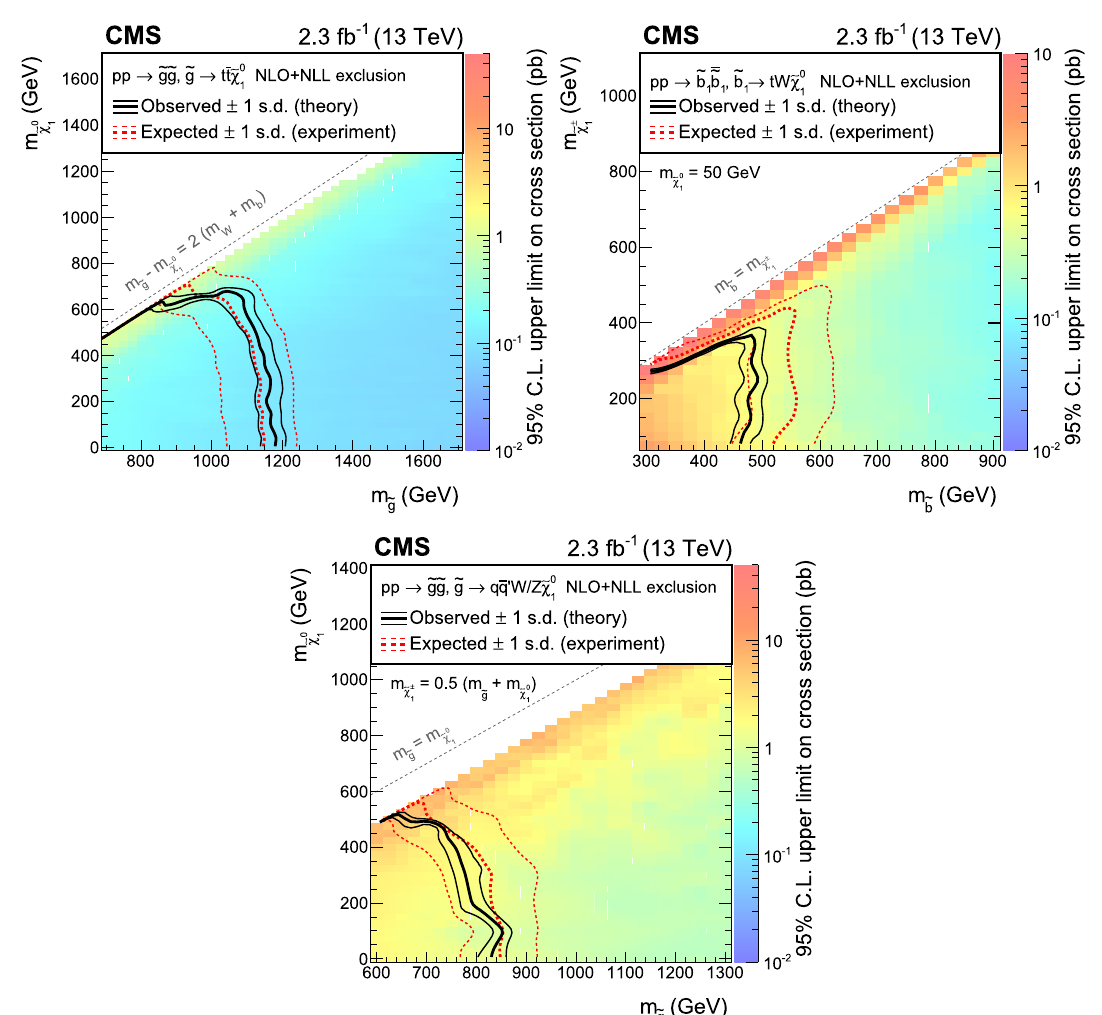
Fig. 4 Exclusion contours as a function of m (cid:2) g or m (cid:2) m (cid:2) χ ± , for the simplified SUSY models (top-left) T1tttt, (top-right) T6ttWW, and (bottom) T5qqqqWZ. The color scale indicates the 95% CL observed upper limits on the cross section. The observed